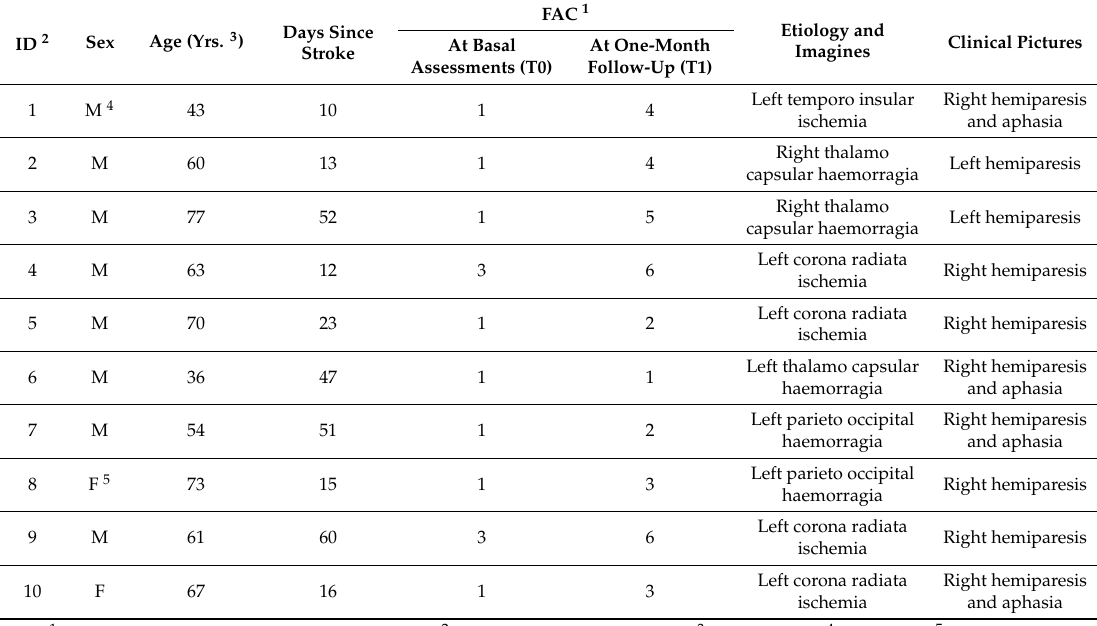
Table 1. Clinical and demographic of the subjects included in the